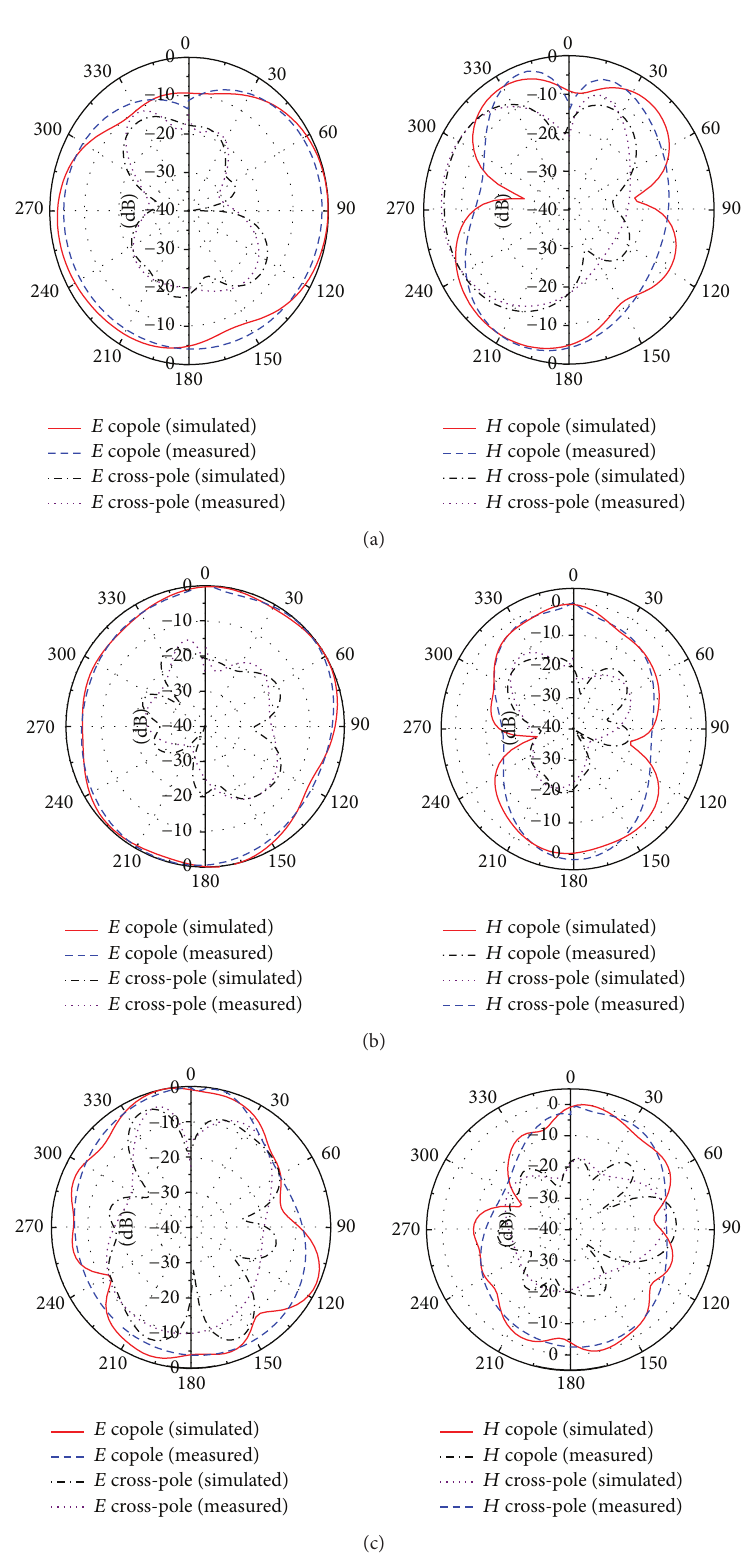
Figure 9: Measured and simulated radiation pattern of various resonance frequencies for the proposed CPW-fed two-sided T strip wideband microstrip antenna (a) at 3.23 GHz, (b) 4.93 GHz, and (c) 7.04